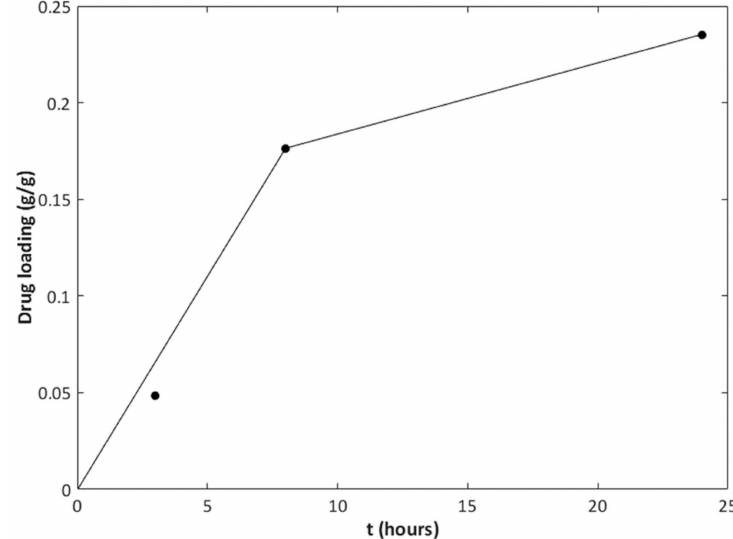
Figure 5. Drug loading of the mesoNsZnO-IBU system versus contact